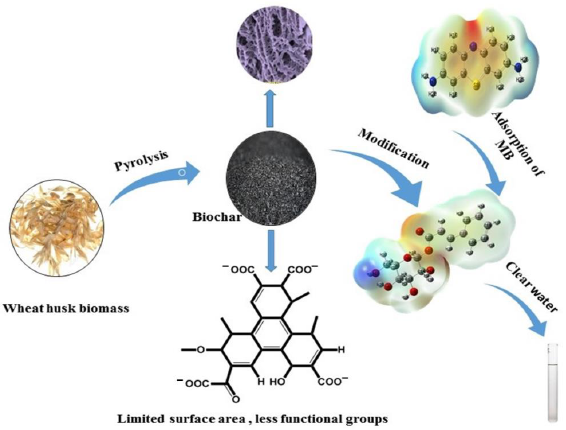
Scheme 1. Schematic representation of modified wheat husk-based wastewater